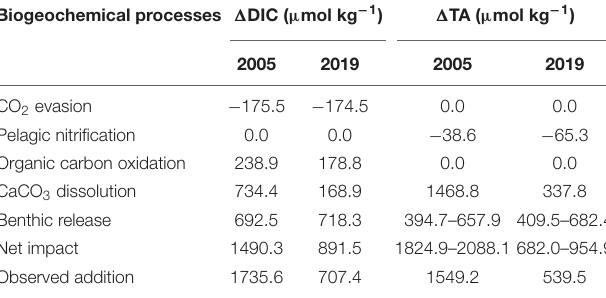
TABLE 2 | Quantified influences of biogeochemical processes on DIC and TA ( (cid:49) DIC and (cid:49) TA) at Guangzhou in January of 2005 and 2019. Biogeochemical processes (cid:49) DIC ( µ mol kg − 1